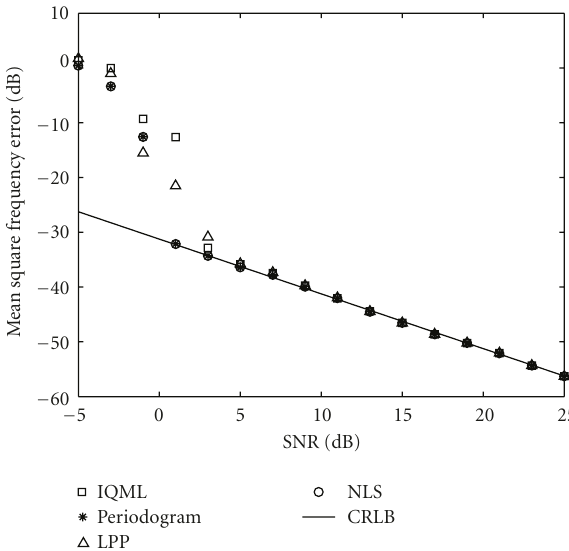
Figure 2: MSE for ω of single complex sinusoid at N =